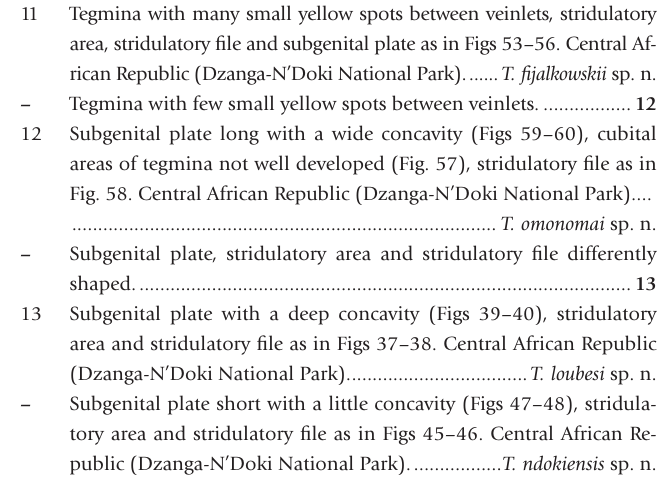
Fig. 58. Central African Republic (Dzanga-N’Doki National Park).